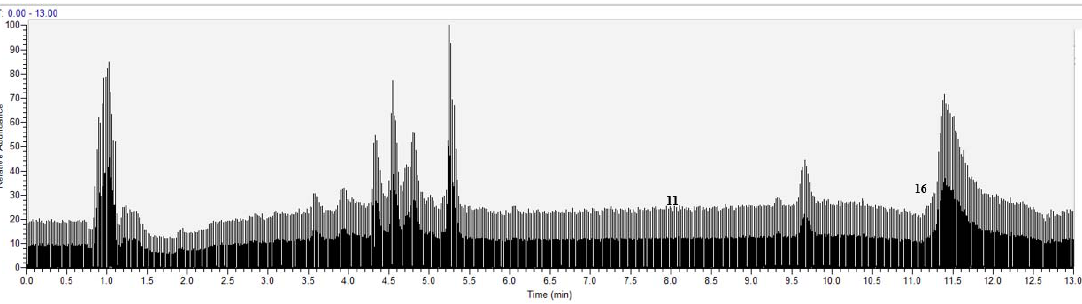
Figure 5. Base peak chromatogram of the elution solution of Choerospondias axillaris by UHPLC-Q- Exactive orbitrap-MS/MS in the negative mode.